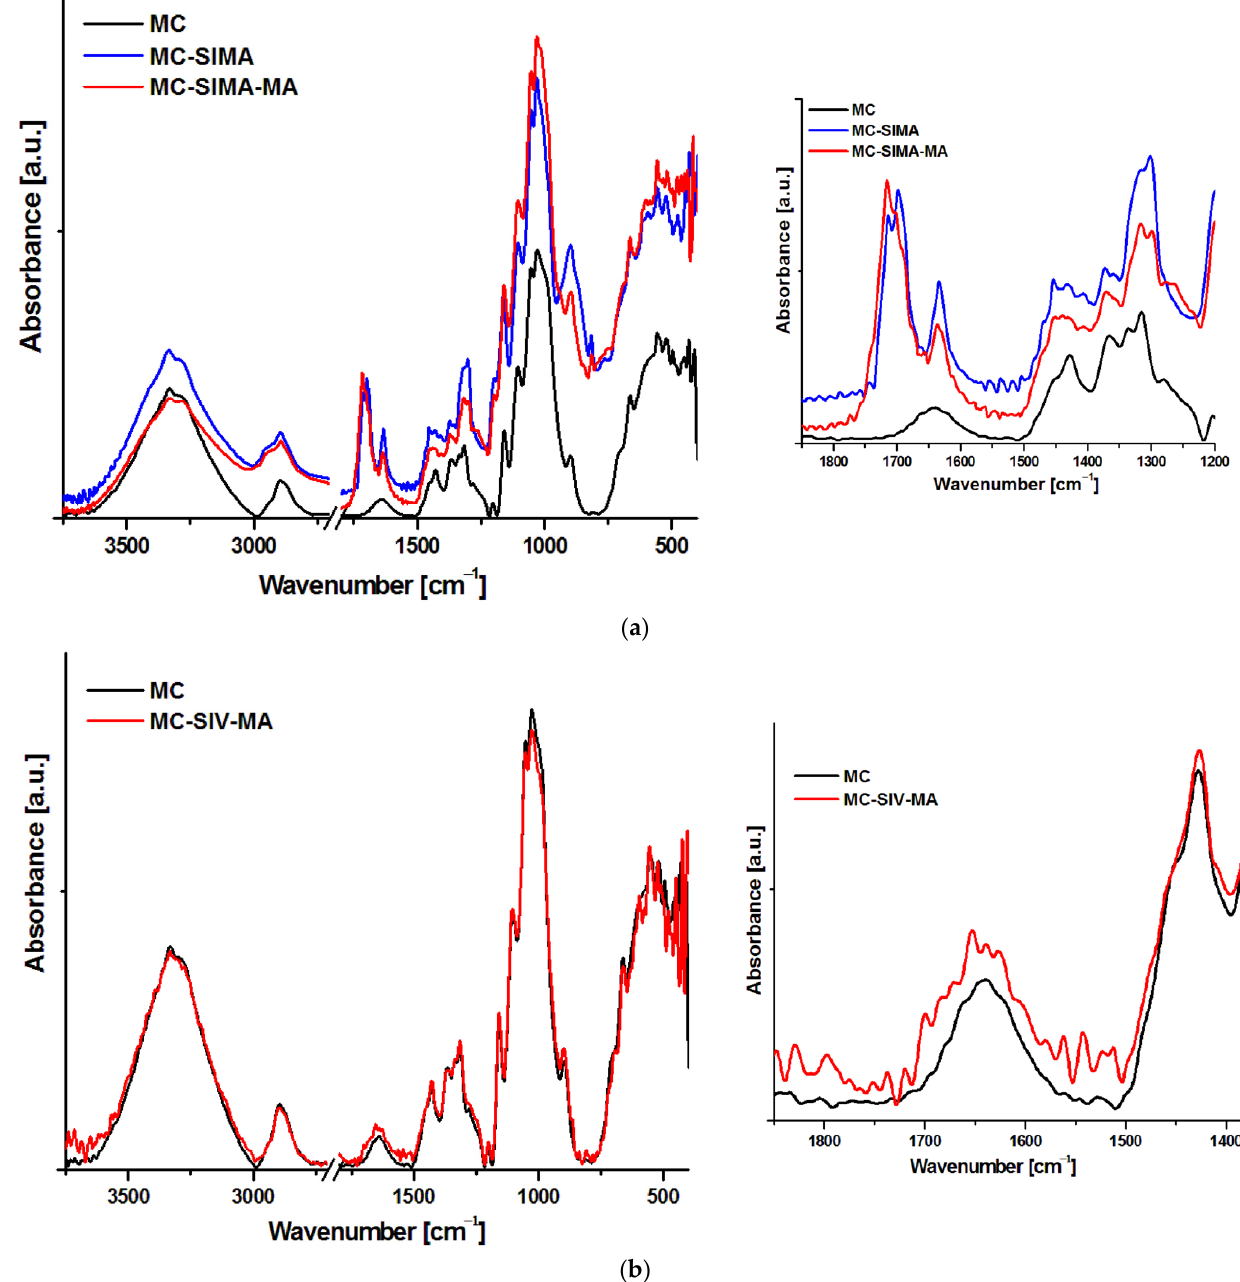
Figure 3. FTIR spectra of MC, MC-SIMA, and MC-SIMA-MA ( a ) and MC-SIV-MA ( b ) . In unmodified cellulose, the peak from 2895 cm − 1 , which is attributed to C–H stretch- ing vibrations, suffers changes after chemical modifications; thus, a shoulder appears in both SIMA-modified celluloses at about 2950 cm − 1 (Figure 3a) due to the stretching of CH 2